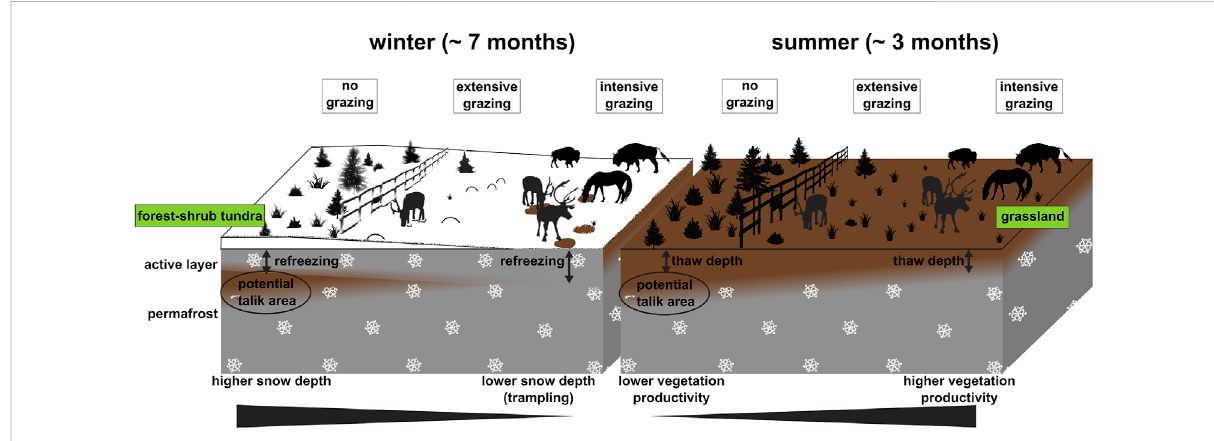
FIGURE 1 GraphicalrepresentationofthePleistoceneParkhypothesis(Zimov2005);Left:duringwintertime(~60%oftheyear),agreaternumberoflarge animals trample down and/orpartly removethesnow cover,facilitating thefullrefreezing oftheactive layer;as theactive layerrefreezesinwinterin thegraminoid-dominatedareas,thawingisreducedcomparedtonon-grazedtundraandforestareas;Right:duringsummertime(~30%oftheyear), a greater number of animals enhances a vegetation shift from shrubby towards graminoid-dominated, increasing vegetation productivity but also ground warming by disturbing the heat insulation layer; since the ground under intensive grazing impact is colder and is fully refrozen at the beginning of summer, overall thaw depth is smaller in these areas by the end of